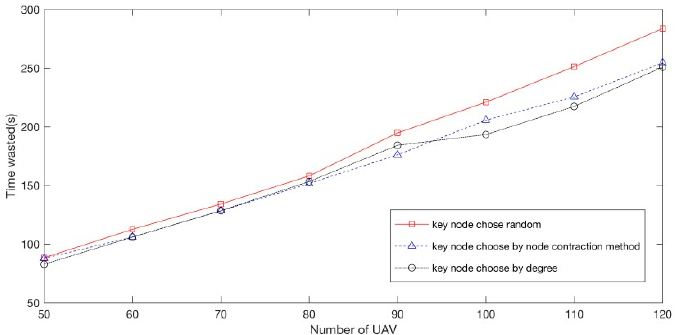
Figure 7. Consuming time of the complex network (CN) algorithm and random approach.